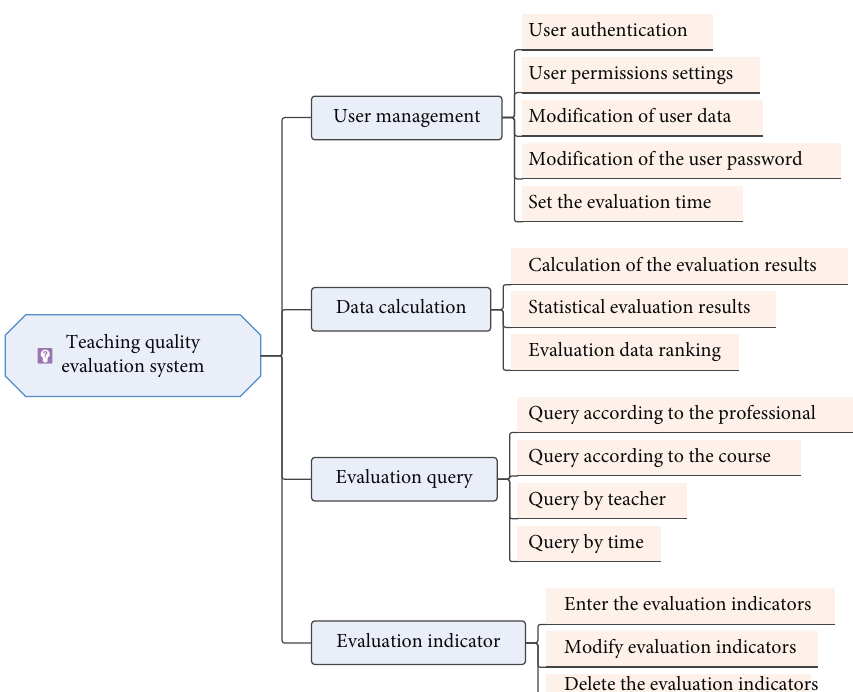
Figure 6: English teaching evaluation system based on Rasch